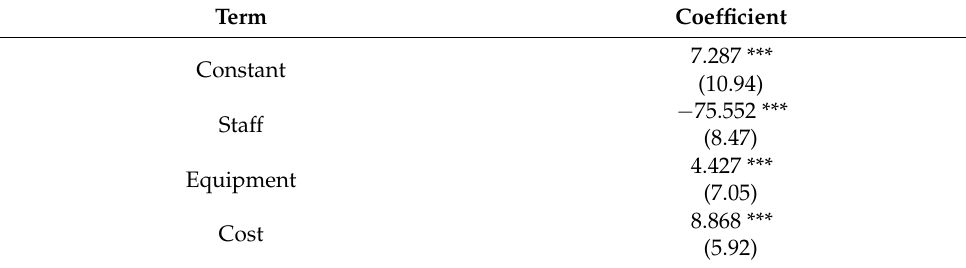
Table 10. Logit regression